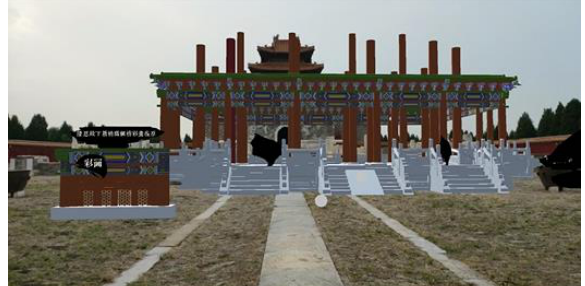
Figure 41. All Gates of Coloured Glaze in Qing Dynasty’s mausoleums